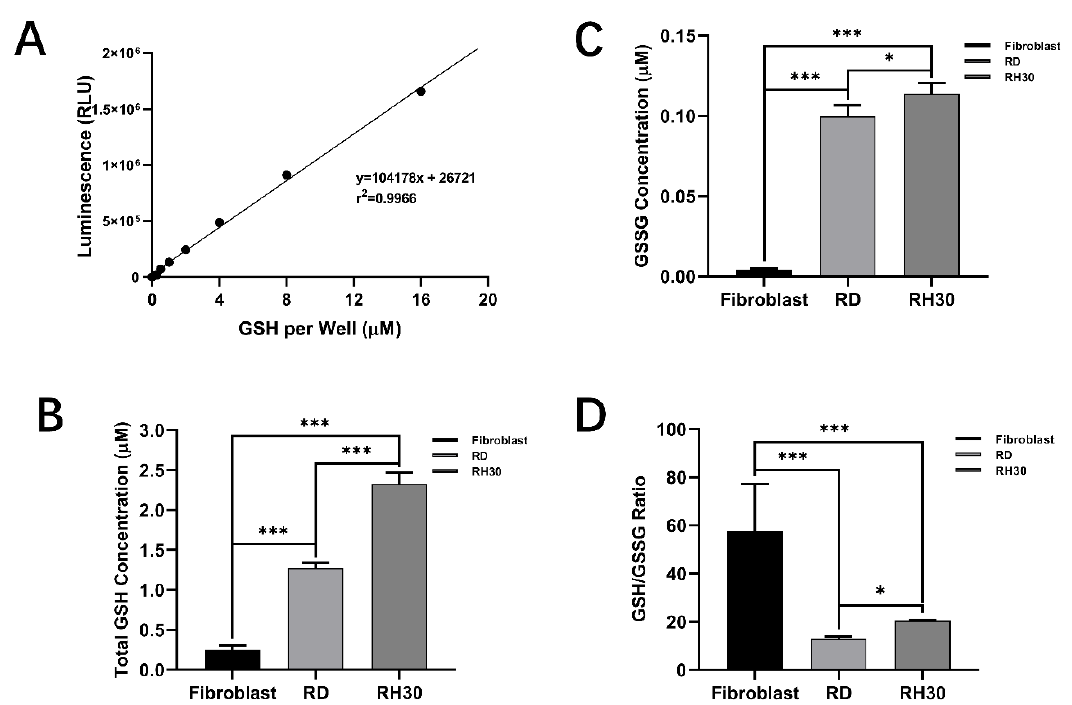
Figure 8. Quantification of intracellular GSG and GSSH concentration and GSH/GSSG ratio. ( A ) Standard curve plotted from eight standards (concentration ranging from 0.25 to 16 μM) which was treated under the same condition as cell samples. ( B ) Quantification of total GSH level of fibroblasts, RD and RH30 cells under the same conditions. ( C ) Quantification of GSSG level of fibroblasts, RD and RH30 cells under the same conditions. ( D ) GSH/GSSG ratio of fibroblasts, RD and RH30 cells under the same conditions ( n = 6). Data are presented as mean ±SD for each individual cell line. Spheroids growth results comparing the cell relative survival rate and metabolism level of RH30 sarcoma cells after treatment with PBS, unbound IR820, SH - MSNPs, IR820 loaded CRYAB and HSPB2 -target siRNA linked MSNPs, or IR820 loaded KRT17-target siRNA linked MSNPs for different periods of times ranging, from 0~72 h ( n = 6). Data are presented as mean ± SD for each individual cell line. Significance was tested using a two tailed t-test compared to the fibroblasts for each cell line (ns: not significant, * p ≤ 0.05 , *** p ≤ 0.001 ).